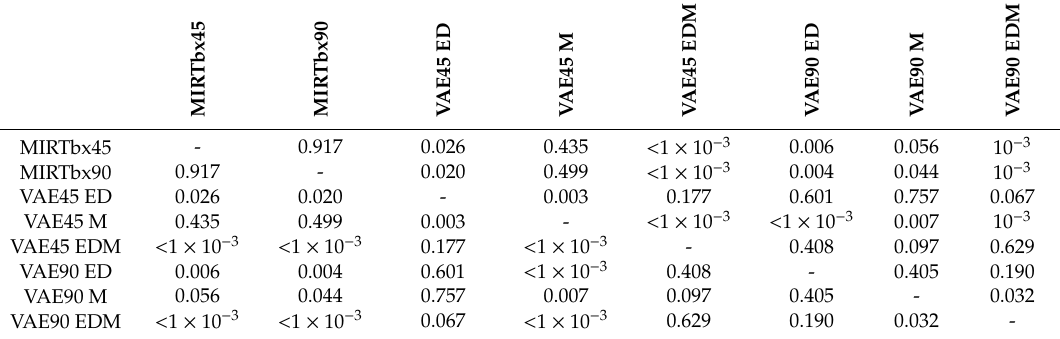
Table 7. Matrix of p -values obtained for Dunn’s post hoc test associated with the NB